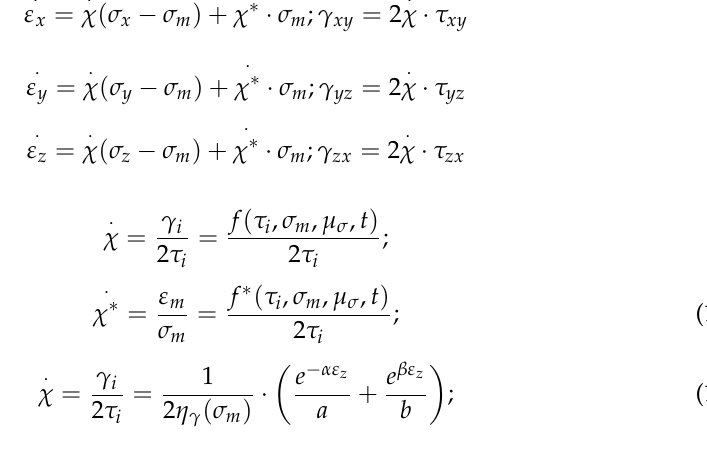
Figure 5. ( a ) τ –t curves made using the kinematic testing results at different values of γ ̇ =const , γ ̇ 1 > γ ̇ 2 > ⋯ γ ̇ 5 ; ( b ) shear stress relaxation curves τ (t) at different initial shear stresses τ (0) and γ = const .